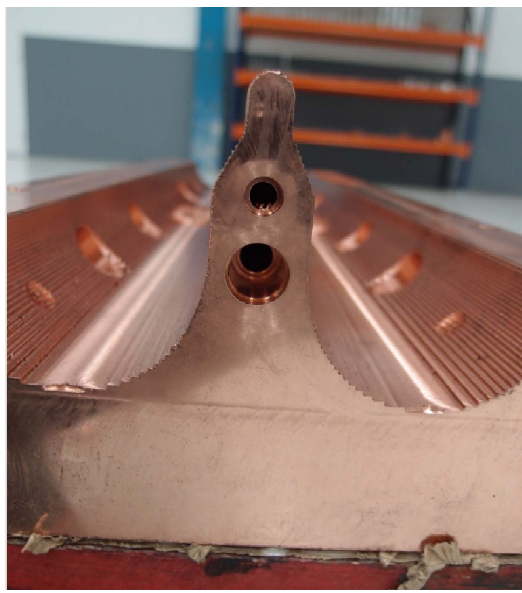
Figure 20. A major vane after rough machining. The holes of the cooling channels can be seen in the